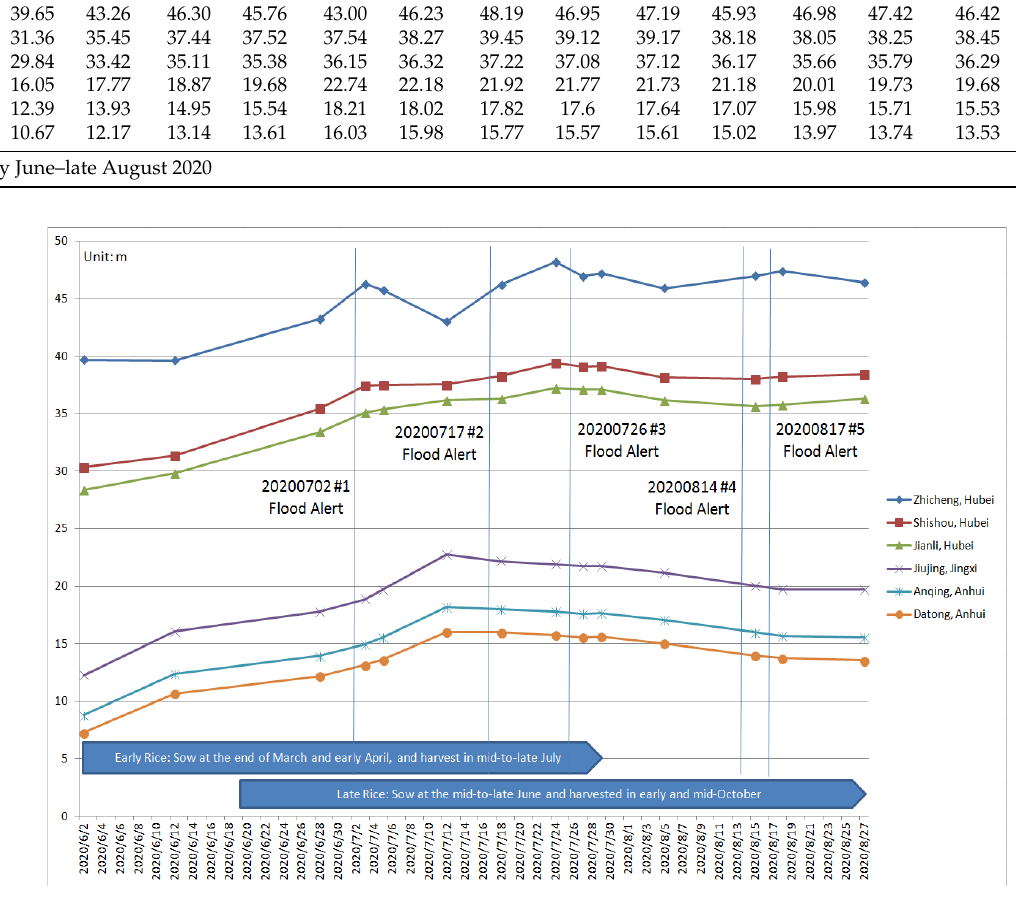
Figure 3. Study area covered by Sentinel-1 images.